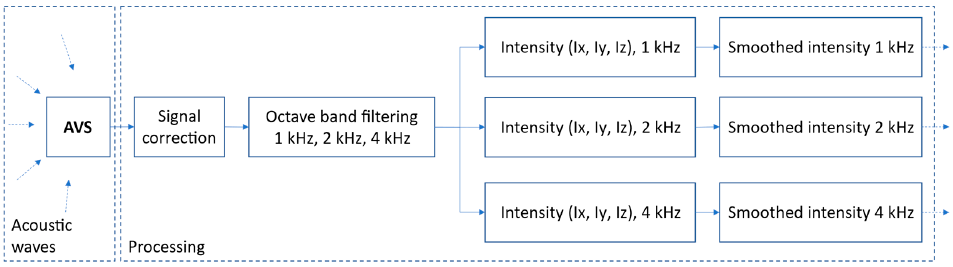
Figure 5. Block diagram of signal preprocessing and calculation of the smoothed intensity signals in frequency bands.